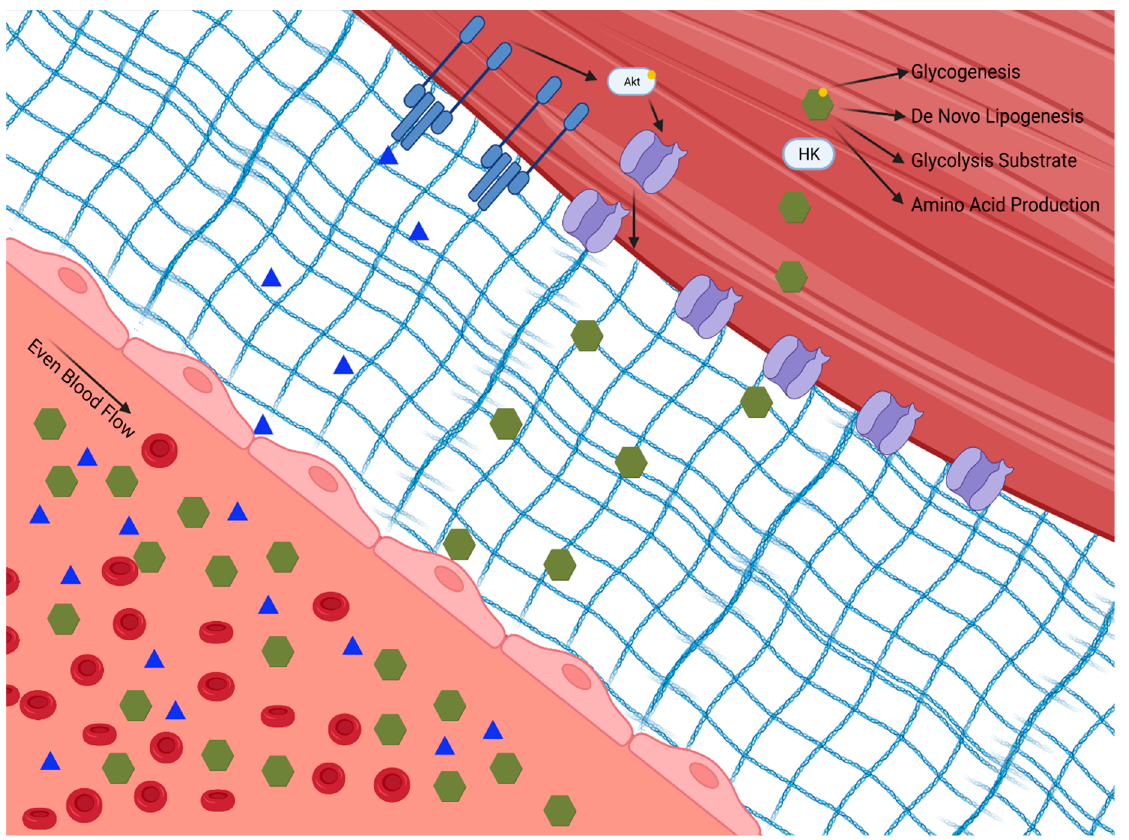
Figure 1. Insulin-dependent and -independent skeletal muscle glucose disposal requires: (1) glucose delivery to the muscle from circulation through the extracellular matrix to the cell membrane; (2) uptake via facilitative glucose transporters either constitutively on the cell membrane or translocated in response to insulin or exercise; and (3) a glucose diffusion gradient to drive glucose into the cell which is modulated by intracellular glucose metabolism. Hexokinase (HK). Phos- phokinase B